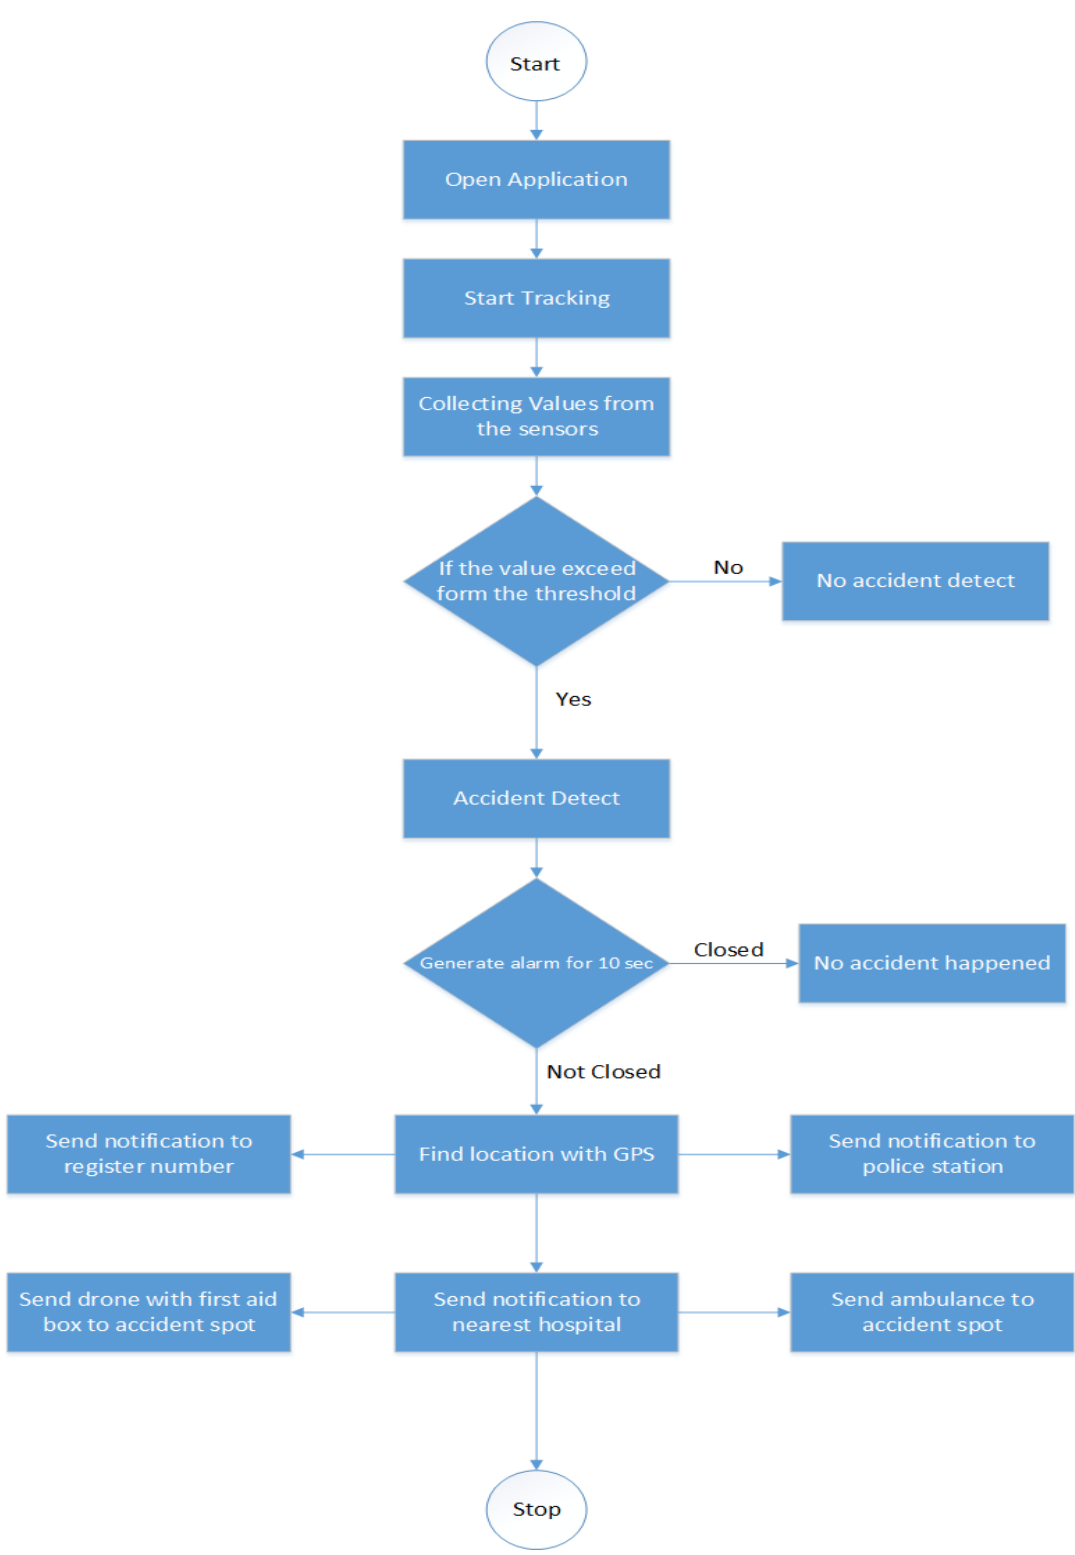
Figure 2. Flowchart of proposed